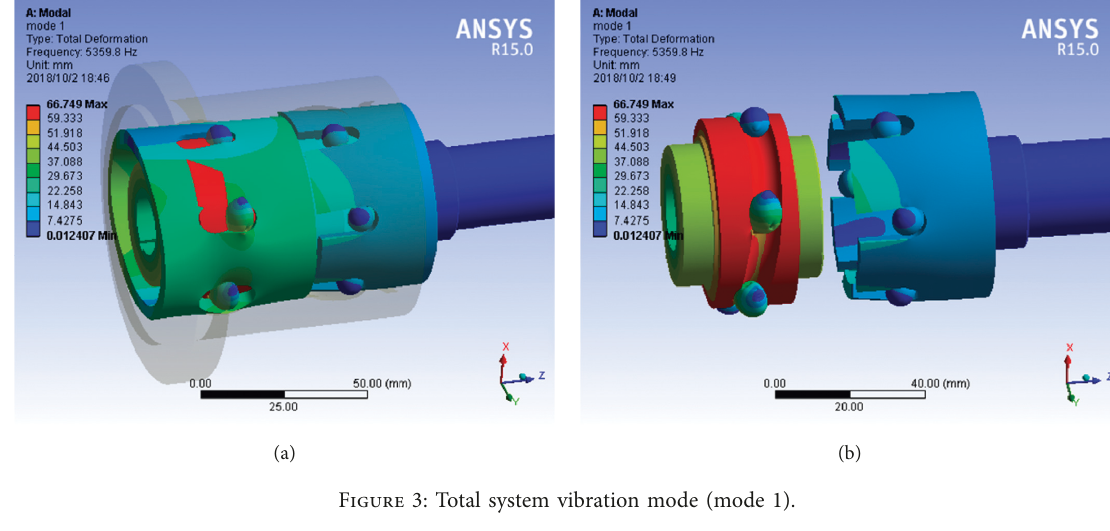
Figure 3: Total system vibration mode (mode 1).